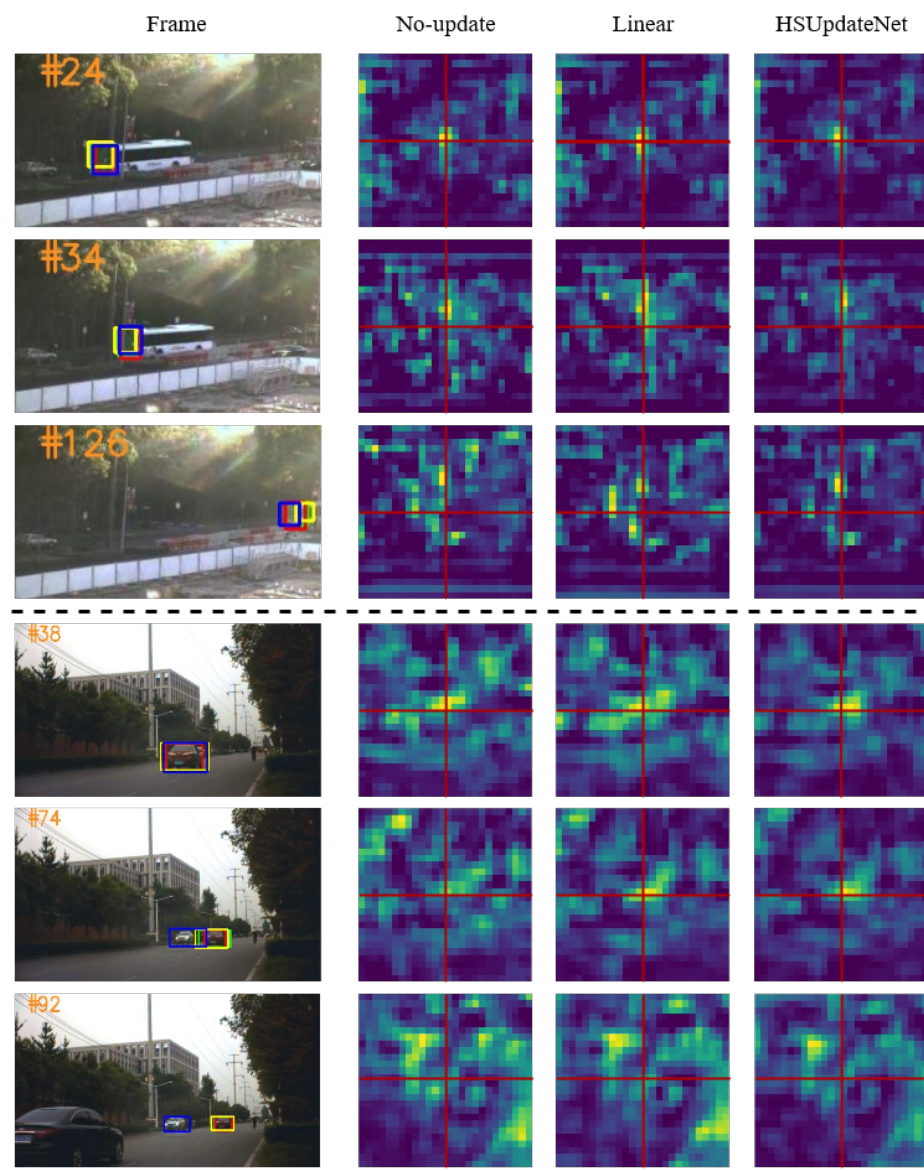
Figure 6. Response maps generated on the search area for different template update strategies. HSUpdate is shown in green, Linear in blue, No-Update in yellow, and ground truth in